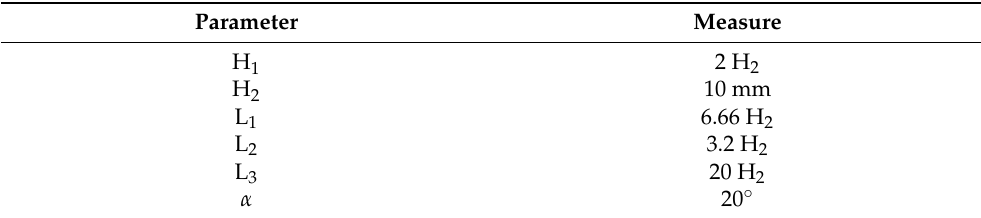
Figure 2. Geometry of the backward-facing ramp including the knitted wire mesh. Table 2. Geometrical parameters of the backward-facing ramp